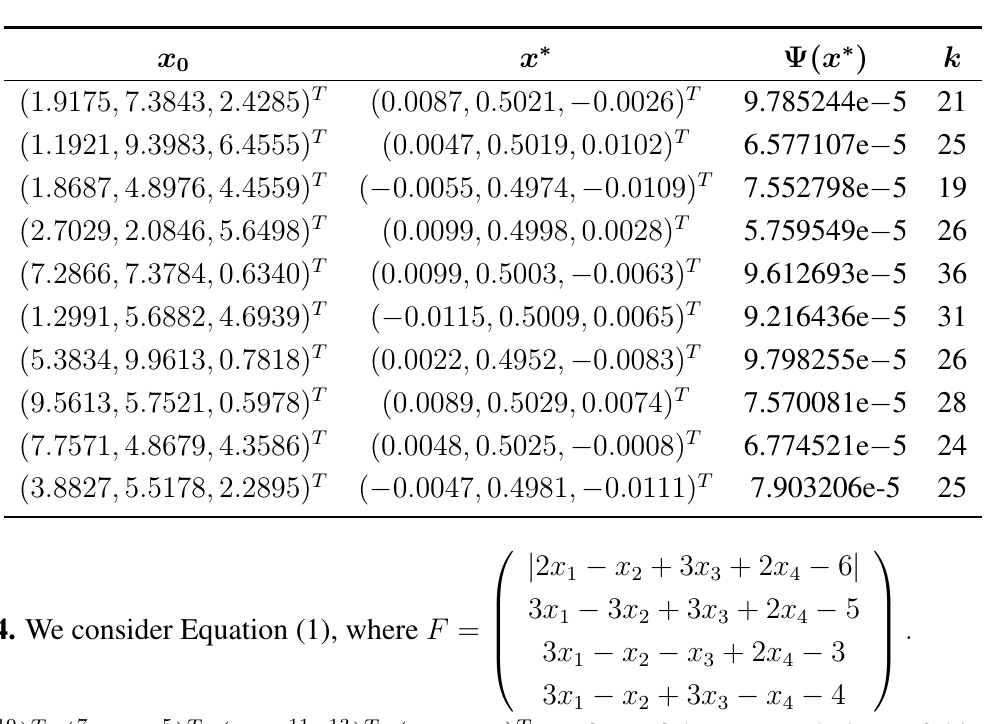
Table 3. Number of iterations and the final value of Ψ( x ∗ ) .